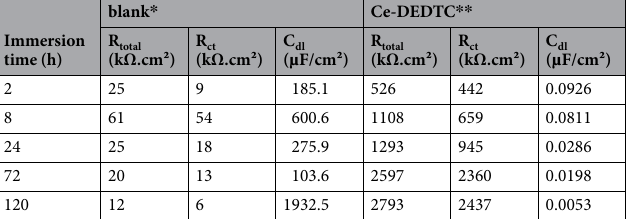
Table 1. The R total , R ct , and C dl values for the blank and Ce-DEDTC specimens versus the immersion time. * Chi-square is between 0.001–0.005. ** Chi-square is between 0.0004–0.003.